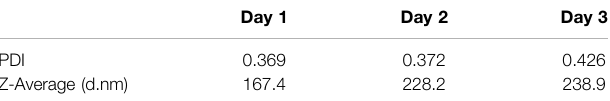
TABLE 2 | Size and PDI value of vesicles of mOMVs stored at 4 ° C during 3